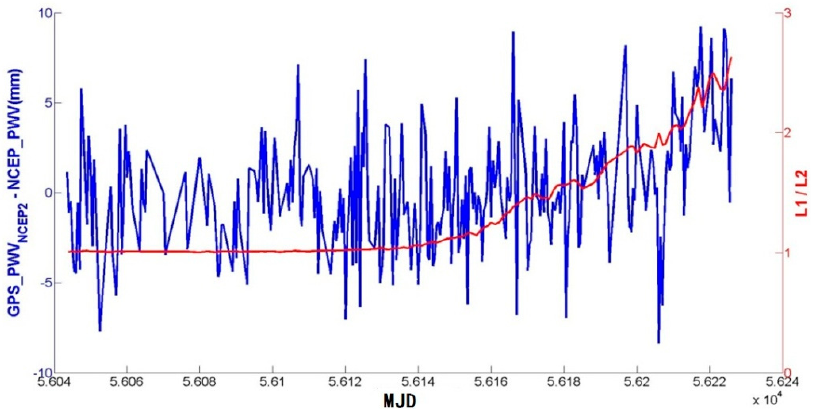
Figure 12. Time series of difference between GPS_PWV NCEP and NCEP_PWV ( blue line) and ratio between observation numbers of L1 and L2 ( red line).